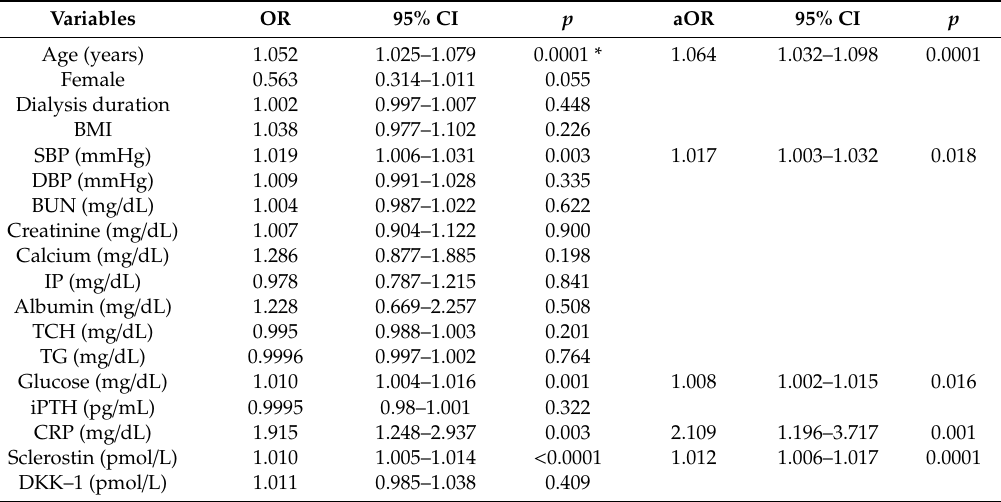
Table 4. Univariate and multivariate stepwise logistic regression analysis of the factors correlated to arterial sti ff ness among 194 dialysis